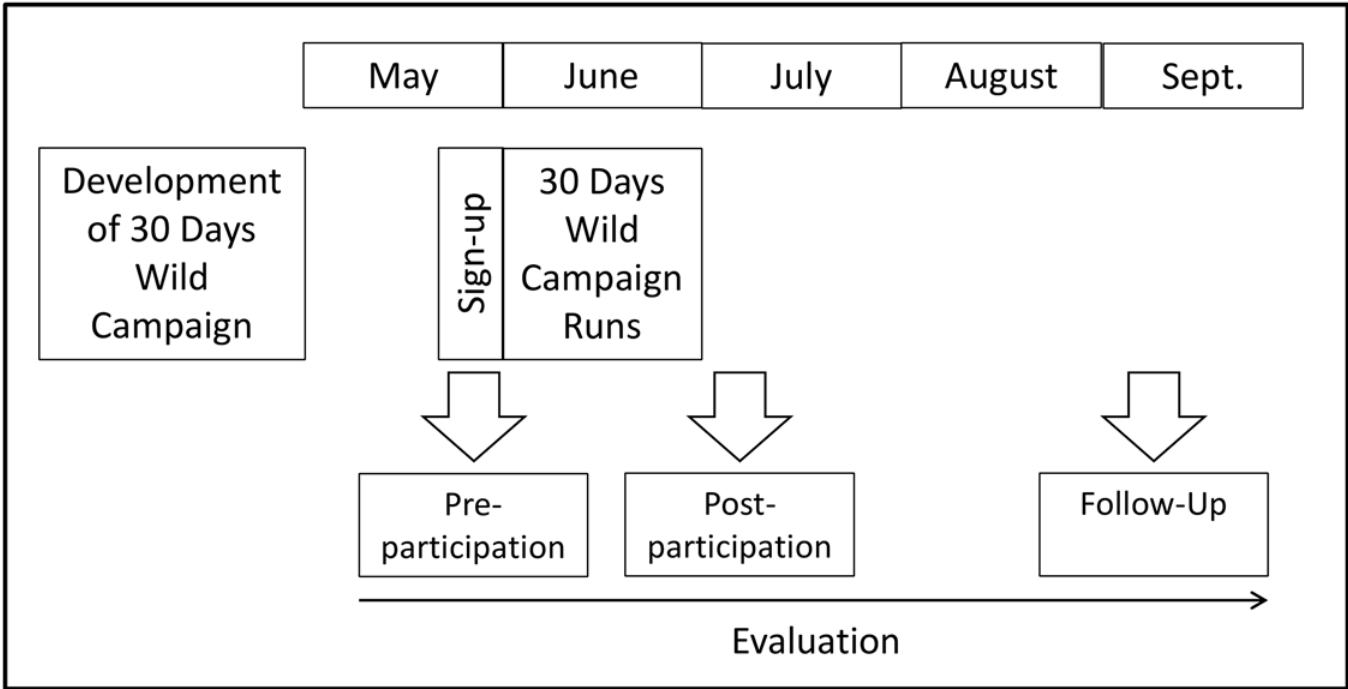
Fig 1. Chronology of 30 Days Wild and its Evaluation.